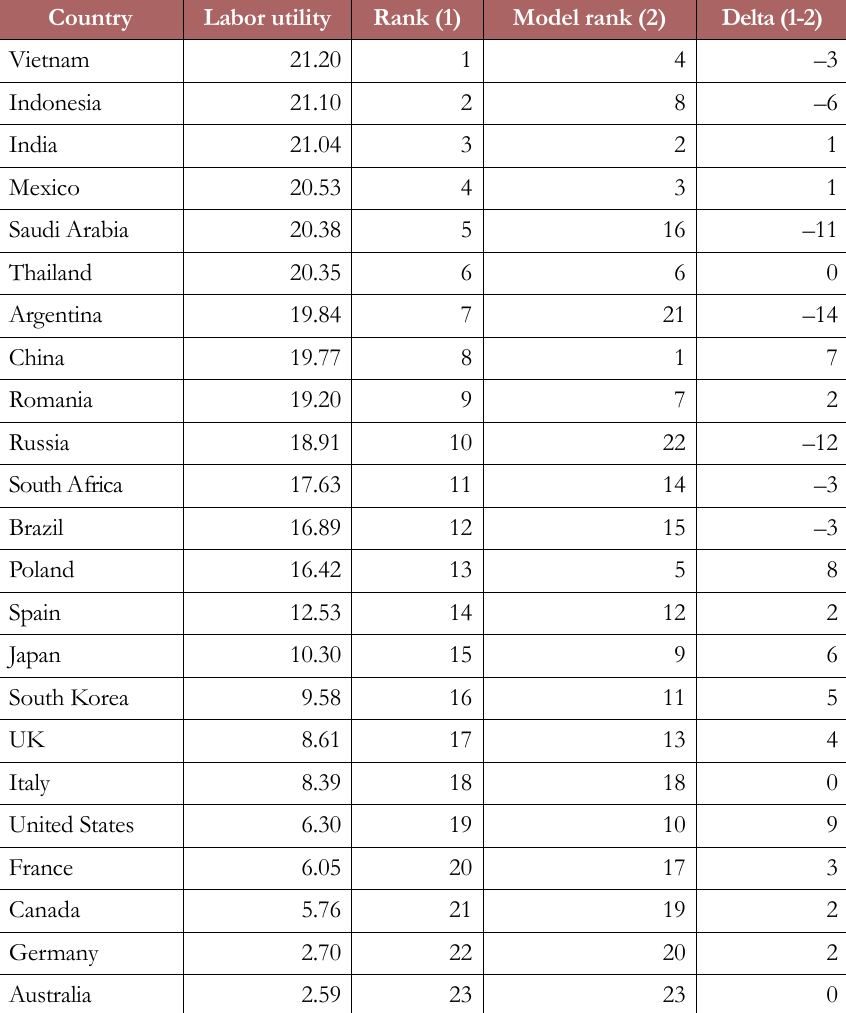
Table 7. Labor rate utility vs. model